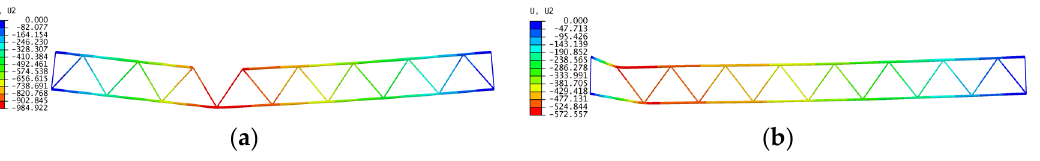
Figure 19. Structural deformation diagram under two working conditions: ( a ) TC4 failure condition, ( b ) WM2 failure condition.